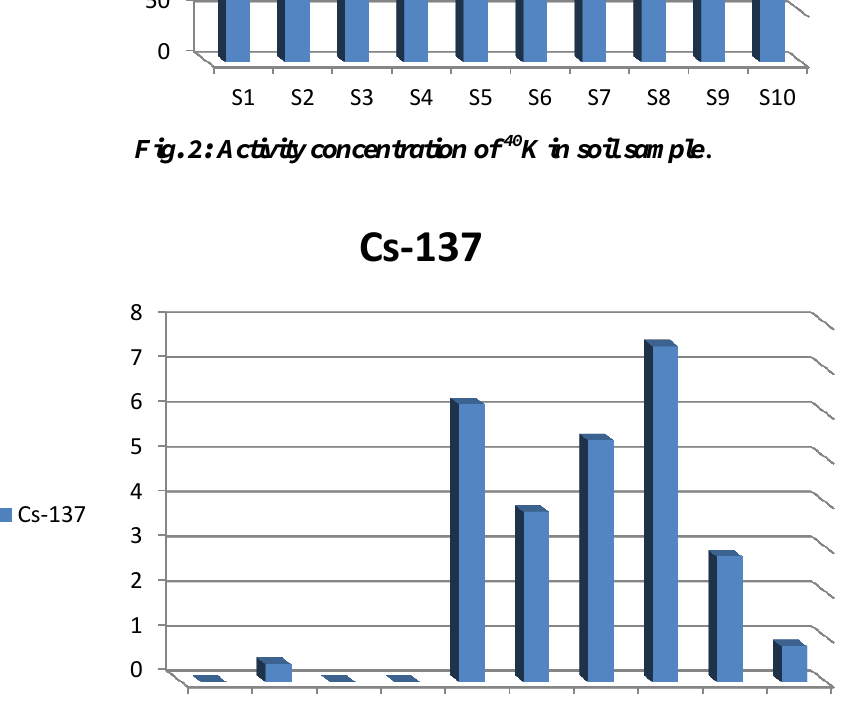
Fig.3: Activity concentration A of radiation for 137 Cs at soil